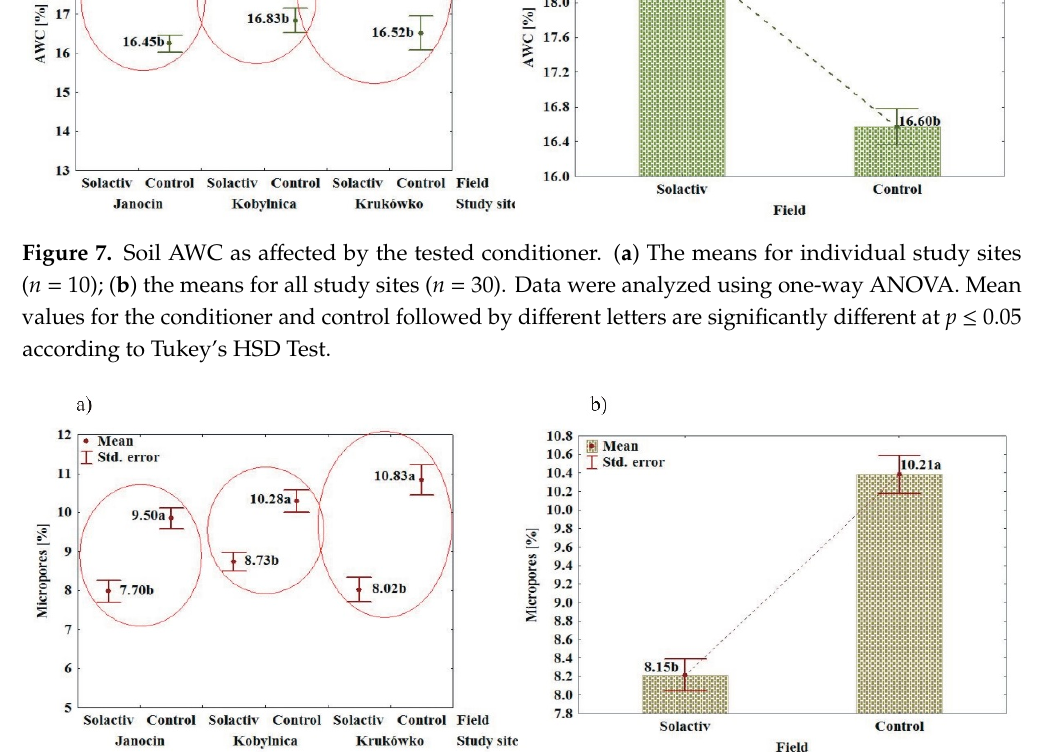
Figure 8. Soil micropores as affected by the tested conditioner. ( a ) The means for individual study sites ( n = 10); ( b ) the means for all study sites ( n = 30). Data were analyzed using one-way ANOVA. Mean values for conditioner and control followed by different letters are significantly different at p ≤ 0.05 according to Tukey’s HSD Test.